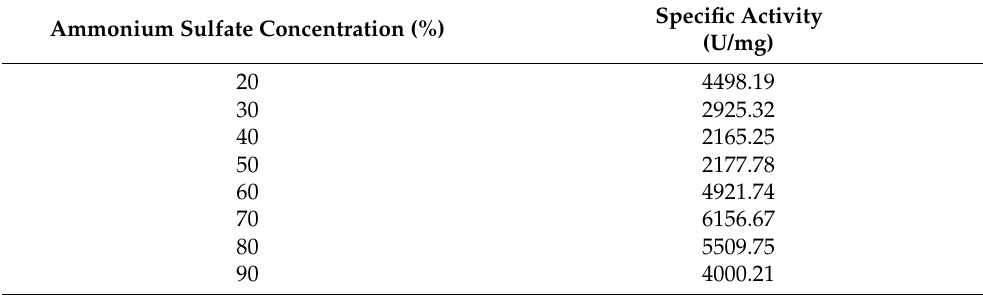
Table 1. Specific activity of the enzyme at different concentrations of ammonium sulfate precipitation.